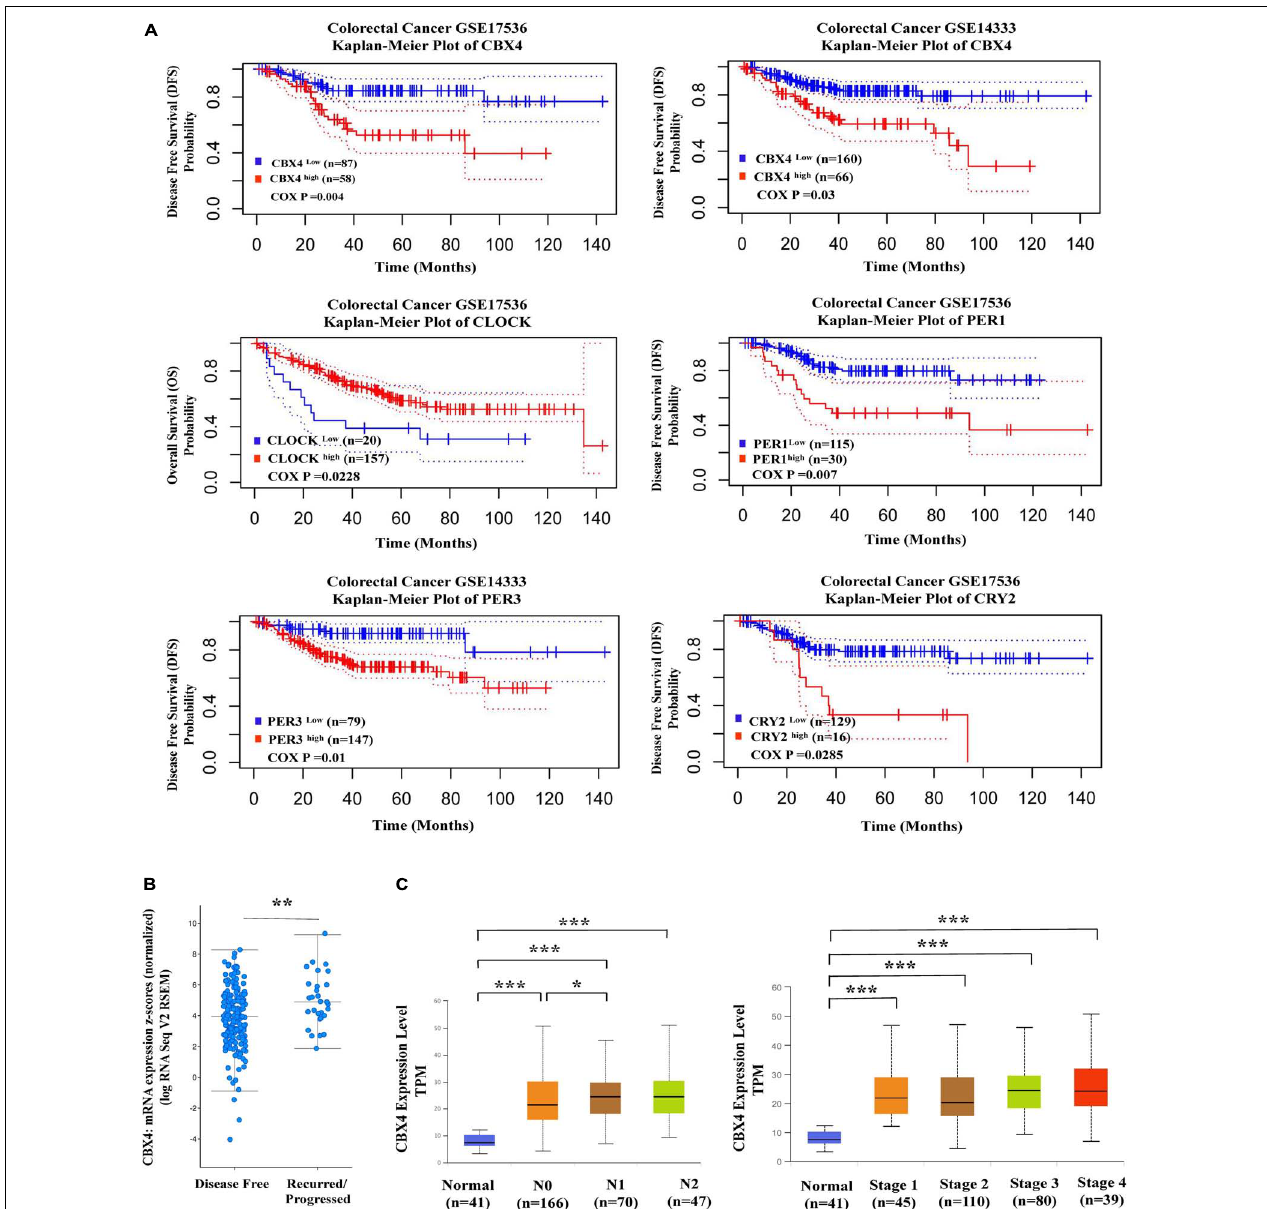
FIGURE 3 | Elevated CBX4 expression predicts poor prognosis in Colon Carcinoma. (A) Shown (upper) are the Kaplan-Meier survival curves comparing the high and low expression of CBX4 in colorectal carcinoma generated by the PrognoScan database. Disease Free Survival (DFS) in two colorectal cancer cohorts GSE17536 ( n = 145) and GSE14333 ( n = 226) was analyzed. Shown (lower) are the Kaplan-Meier survival curves comparing the high and low expression of the core clock gene PER1, PER3, CLOCK, and CRY2. DFS or Overall survival (OS) in two colorectal cancer cohorts GSE17536 and GSE14333 was analyzed. The X-axis represents months to follow-up and the Y axis is survival rate, 95% confidence intervals for each group are indicated by dotted lines. (B) Based on the study of Colorectal Adenocarcinoma (TCGA, PanCancer Atlas), levels of CBX4 mRNA expression (log RNA Seq V2 RSEM) ( n = 222) were compared between the recurred/progressed colon cancer cases ( n = 29) and the disease-free samples ( n = 193). The data were collected from the clinical attribute of the study. The vertical axis represents CBX4 mRNA expression (z scores relative to normal samples), and the horizontal axis is the categories of disease free status. (C) The correlation of CBX4 expression with colon adenocarcinma metastasis was analyzed using UALCAN. Levels of CBX4 expression was normalized in TPM. For the nodular metastasis status, N0 is no regional lymph node metastasis; N1 is Metastases in 1 to 3 axillary lymph nodes; N2 is Metastases in 4 to 9 axillary lymph nodes. For the cancer stages, Stage I: T1 or T2 N0 M0; Stage II – T3 or T4 N0 M0; Stage III – Tx N1 or N2 M0; Stage IV – Tx Nx M1. * P < 0.05, ** P < 0.01, *** P <